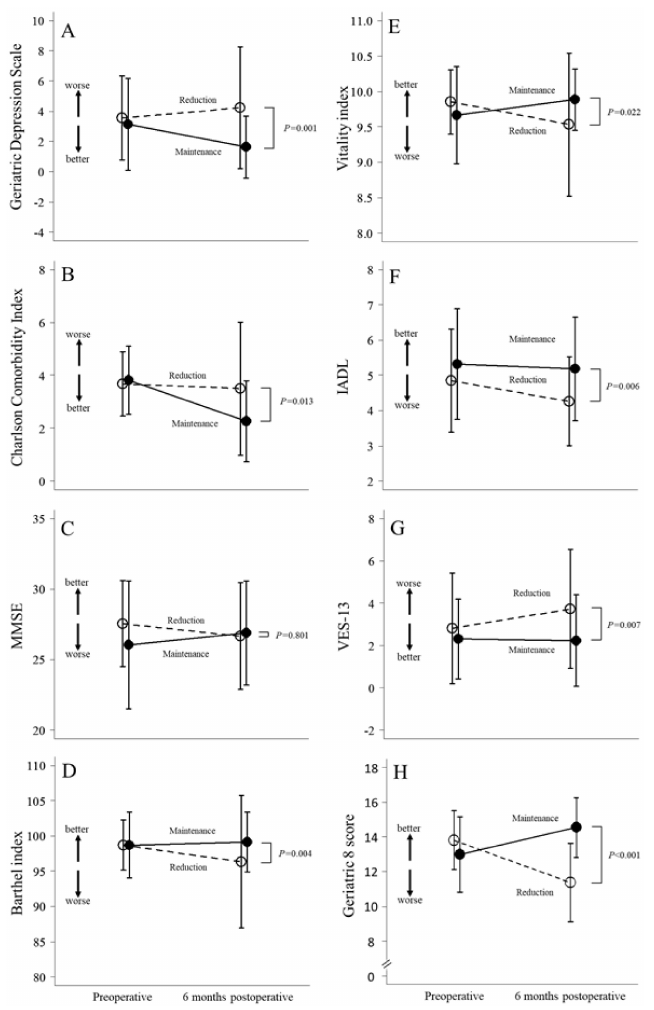
Figure 1. Perioperative changes in eight geriatric assessments between the maintenance and reduction